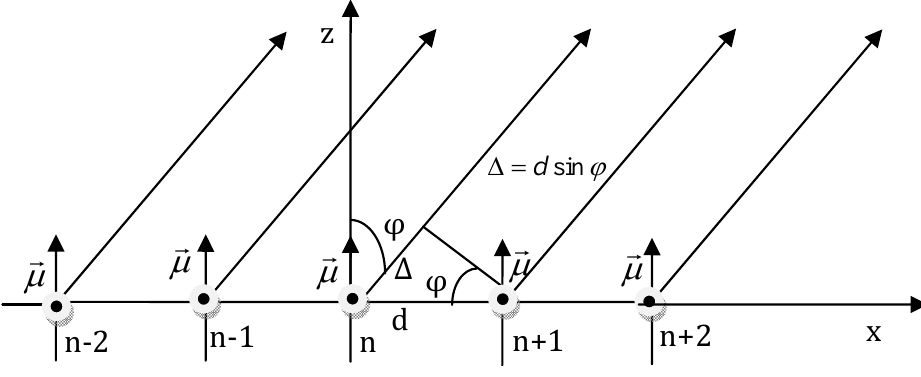
Figure 6. Scattering of electrons by linear chains of